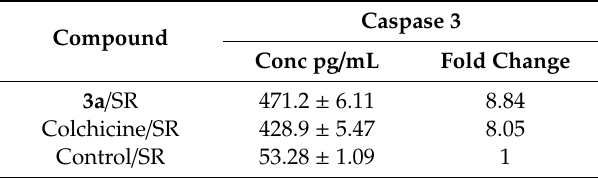
Table 7. Caspase-3 conc (pg / mL) ± SD and fold change levels for compounds 3a and colchicine on leukemia SR cell line.